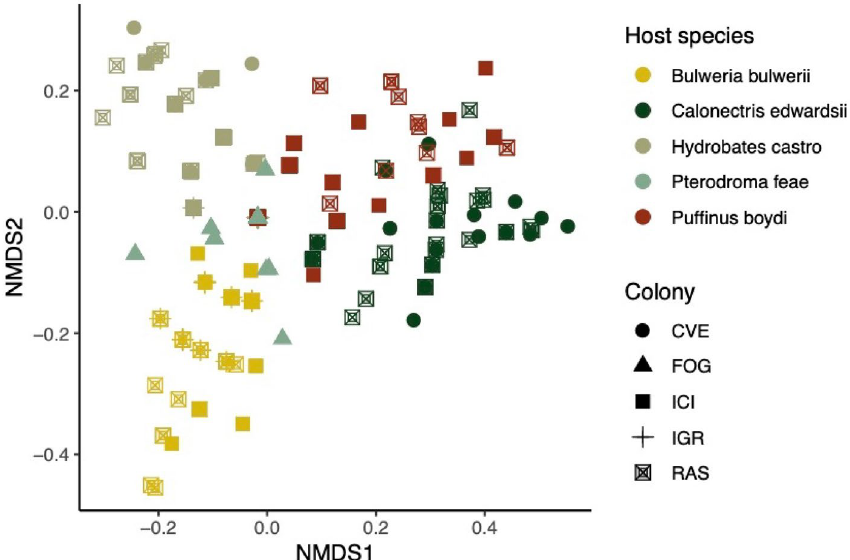
Figure 3. Non-metric multidimensional scaling ordination plot based on Jaccard similarities (data non- transformed, stress = 0.103) of mite infracommunities for five procellariiform species breeding in different colonies of the Cape Verde Islands. Each host species and sampled colony is represented by its own colours and icons, respectively. Abbreviations of the colonies are: Curral Velho—CVE, Fogo—FOG, Ilheu Cima—ICI, Ilheu Grande—IGR,